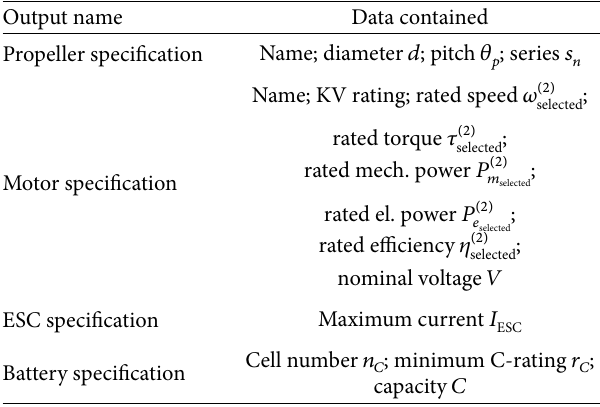
Table 2: Data contained in sizing methodology